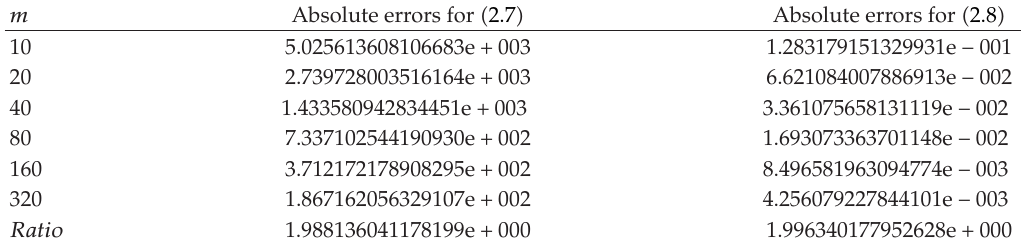
Table 1: The explicit Euler method for (cid:6) 2.7 (cid:7) and (cid:6) 2.8 (cid:7)